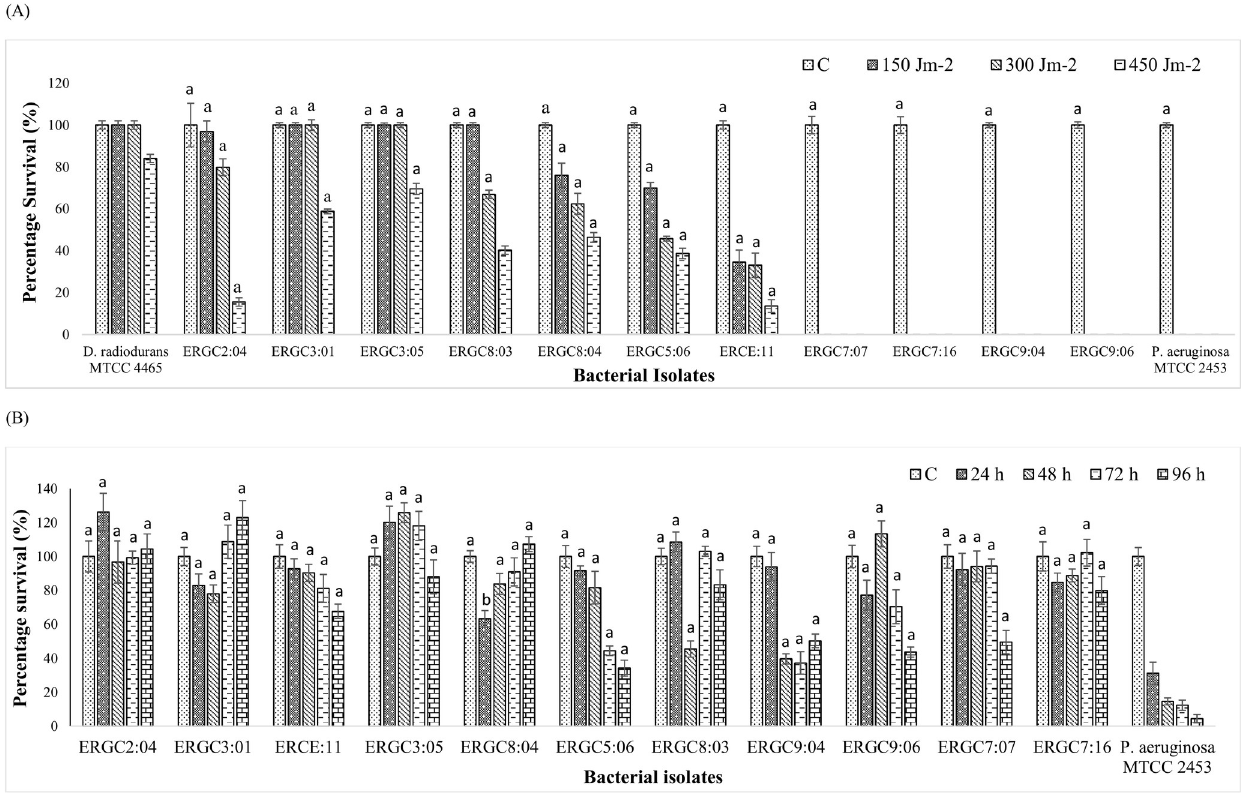
Fig 4. Tolerance of the 11 Pseudomonas strains to (A) UV-C irradiation at 150, 300, and 450 Jm -2 , (B) freezing for 96 h, whereby percentage survival was calculated relative to the colony count of non-irradiated and unfrozen control as 100%, respectively. The mean of triplicate colony count was used to calculate percentage survival. Error bars denote the standard deviation of the mean of the three biological replicates (n = 3). Letters a, b denotes significant differences between the (A) positive control strain ( Deinococcus radiodurans MTCC 4465) and test strains and (B) negative control strain ( Pseudomonas aeruginosa MTCC 2453) and test strains; at p < 0.0001 and p < 0.0002, respectively, using one-way ANOVA by Dunnett’s multiple comparison test.